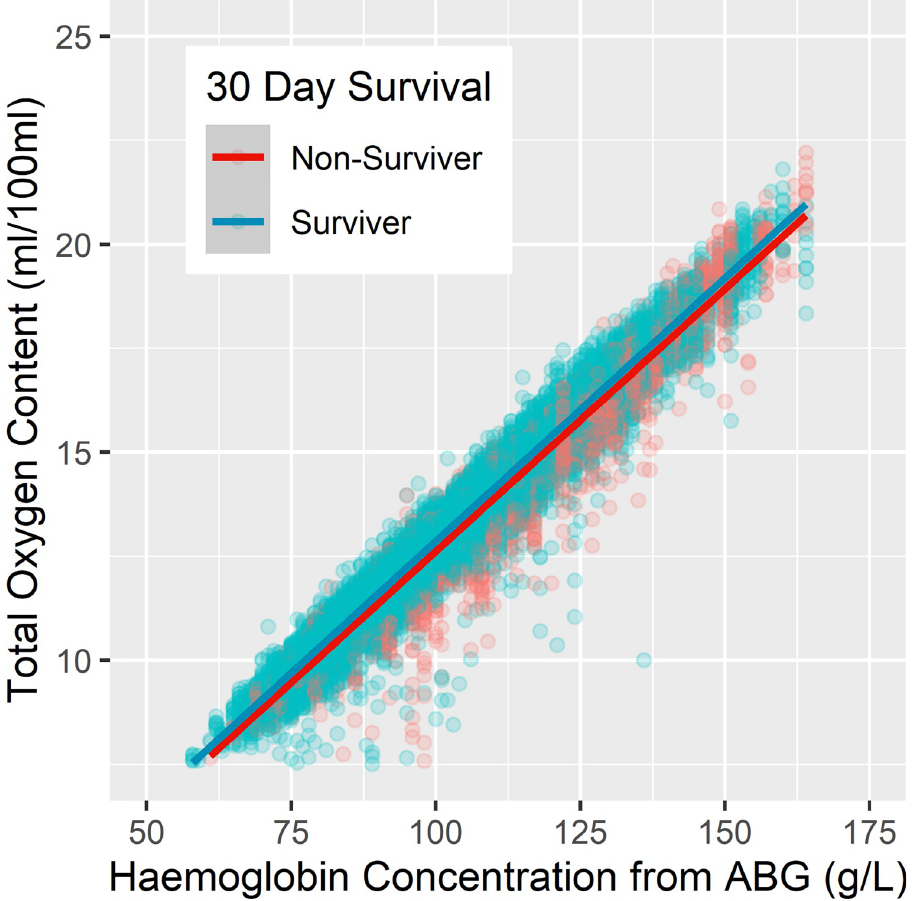
Fig 3. The correlation between oxygen content and haemoglobin.